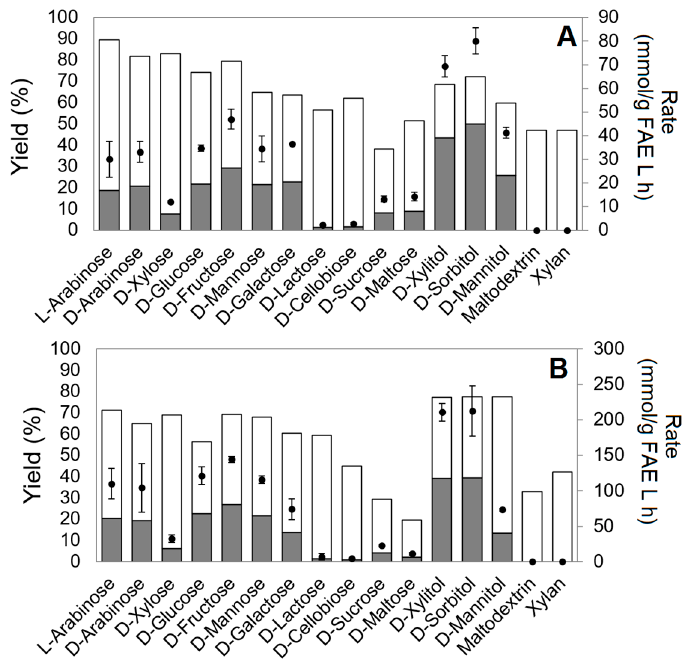
Figure 4. Synthesis of sugar esters by ( A ) C1FaeA1 and ( B ) Fae125. Reaction conditions: 50 mM VFA, 50 mM sugar (except for 30 mg/mL xylan or maltodextrin), 0.1 mg protein mL − 1 , 19.8:74.7:5.5 v / v / v n -hexane: t -butanol: buffer, 45 ◦ C, no agitation, 8 h of incubation. Grey column: transesterification yield; white column: hydrolysis yield; black circle: specific rate of transesterification. The error bars represent the standard deviation between two duplicates.